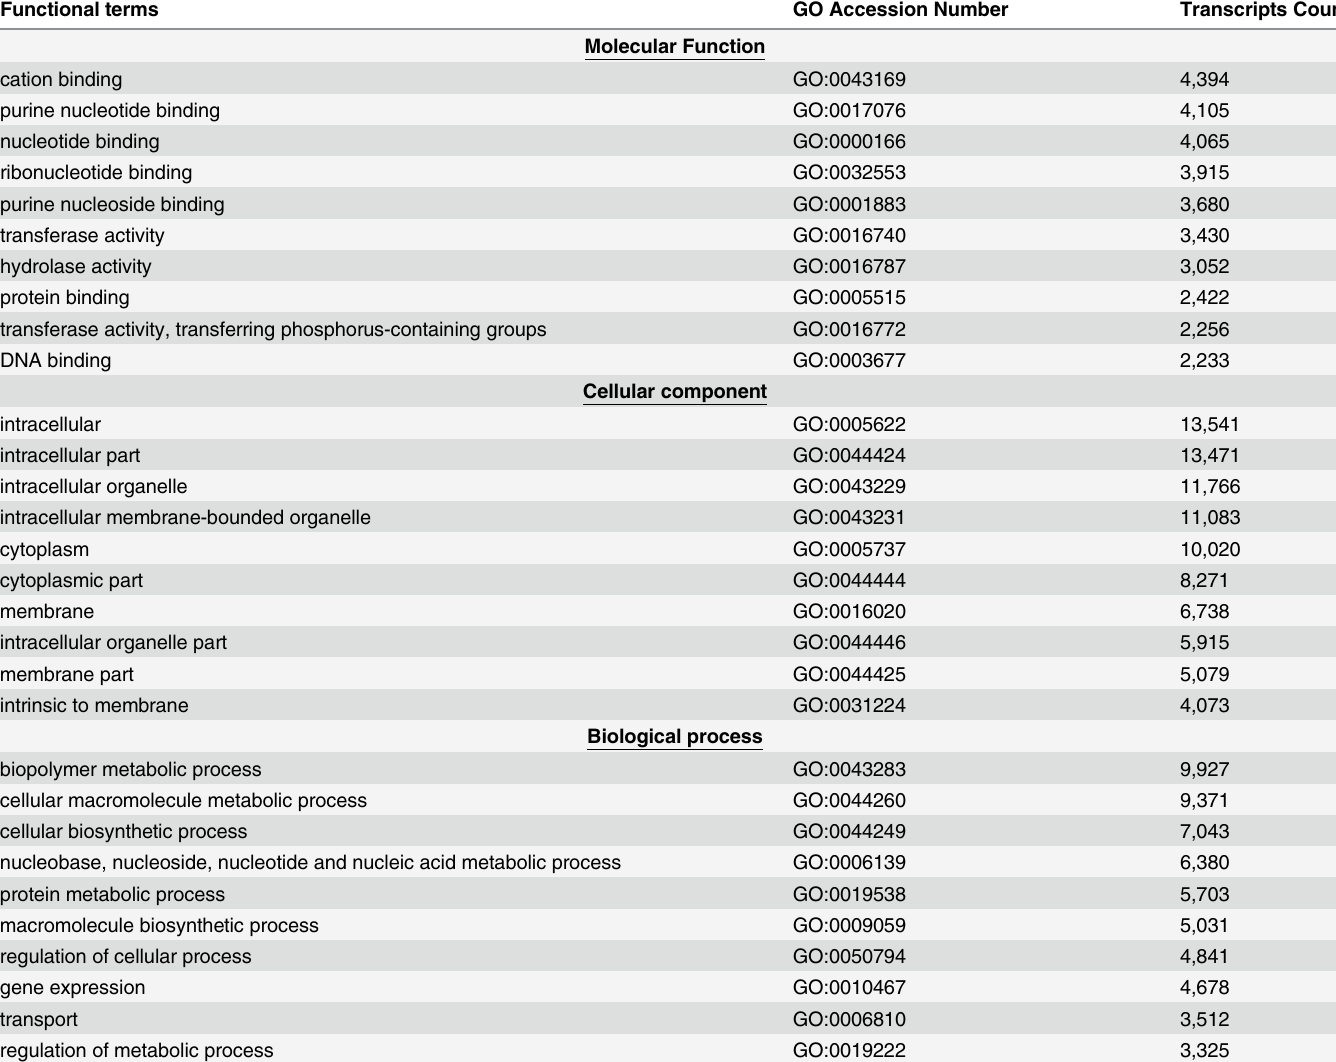
Table 3. The top 10 GO terms with the highest transcript number in each of the three